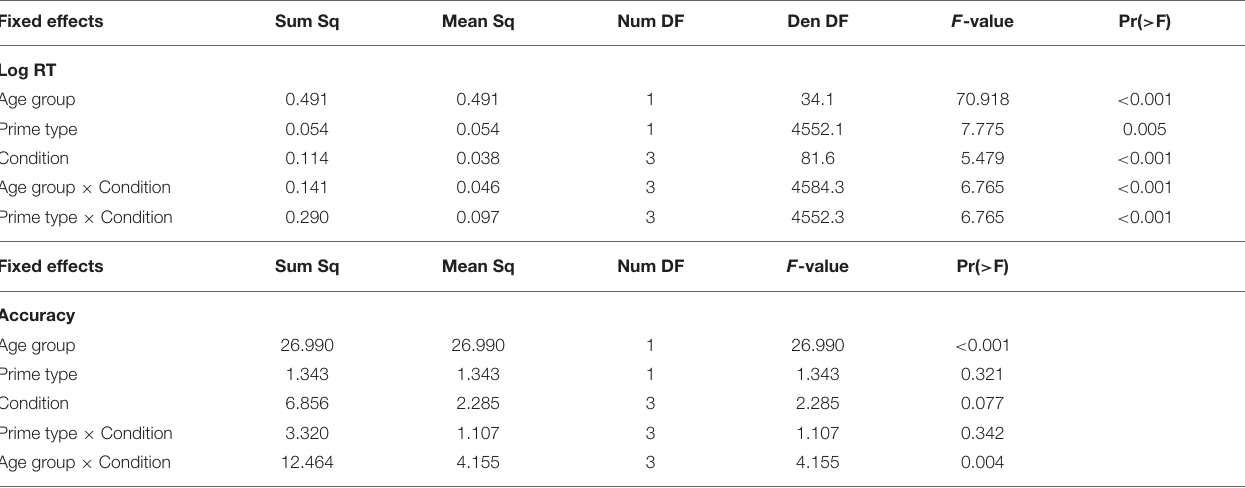
TABLE 6 | Results from the ANOVA approach to linear mixed-effects model analysis of log RT and accuracy rates in Experiment 2 with 48ms prime